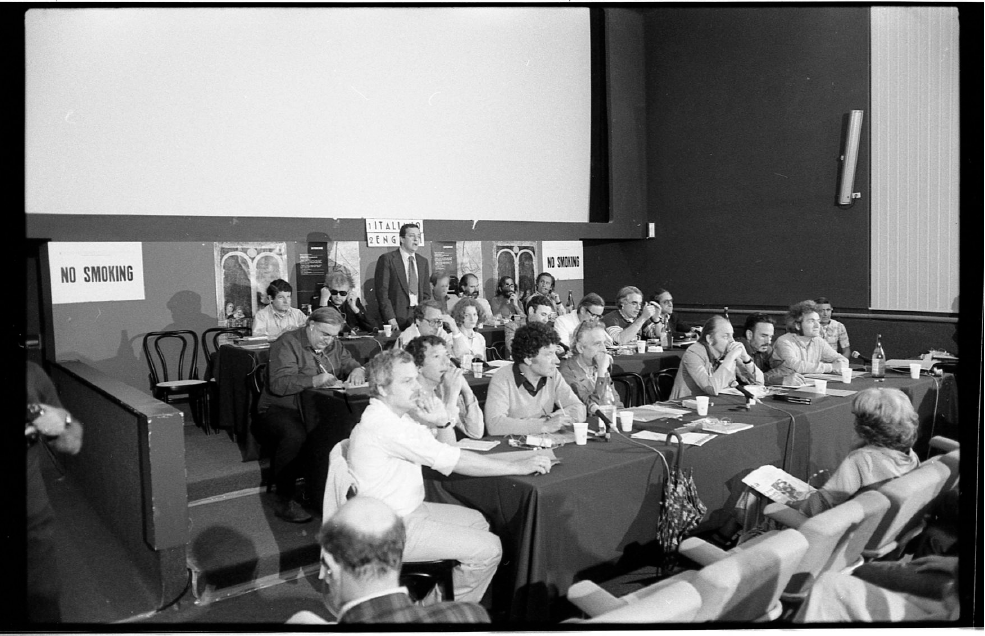
Figure 5. A photograph taken during the debate “Quale movement moderno?” in the Palazzo del Cinema in Lido. We can see the following participants in the aforementioned debate: Stanley Tigerman, John Hejduk, Carlo Ripa di Meana, Joseph Rykwert, Lucien Kroll, Alvaro Siza, Oriol Bohigas, James Stirling, Robert Venturi, Denise Scott Brown, Emilio Ambasz, Carlo Aymonino, Peter Eisenman, Robert Stern, Jean Deroche, Paul Chemetov, Aldo Van Eyck, Hans Hollein, Giancarlo de Carlo, Herman Hertzberger, and Aldo Rossi. Source: Archive Storico delle Arti Contemporanea (ASAC), La Biennale di Venezia.